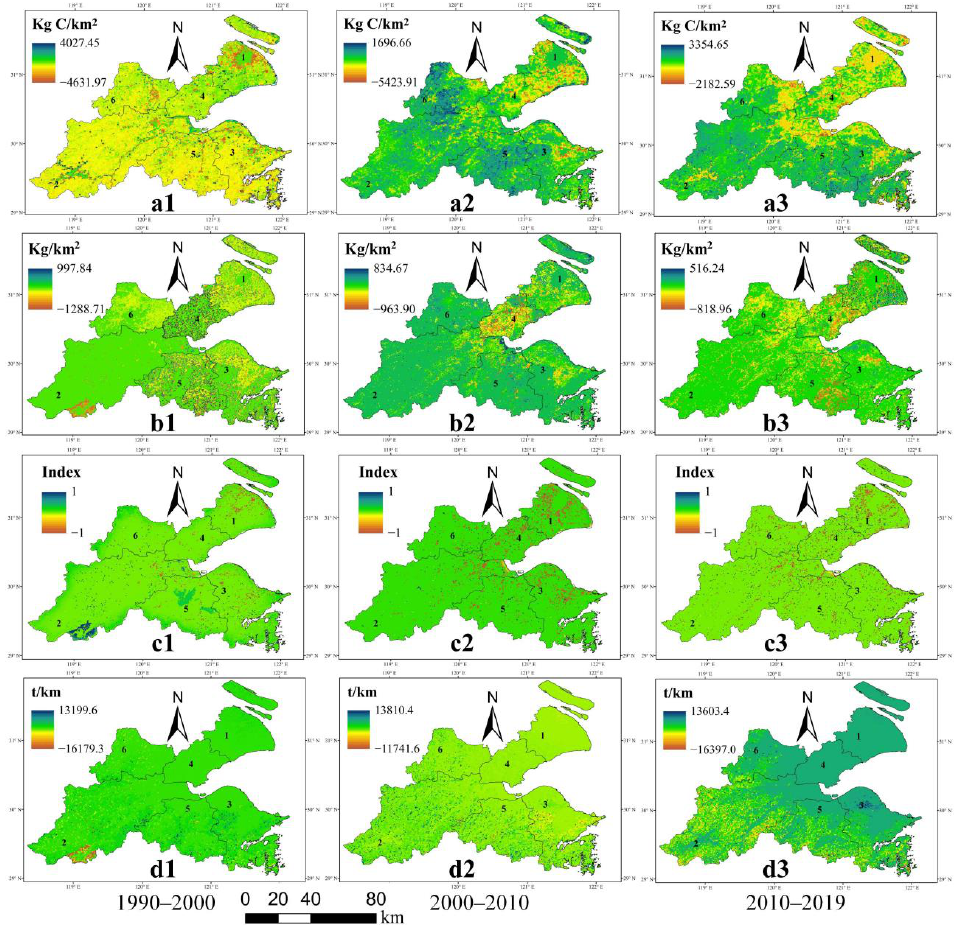
Figure 8. Spatial differences of ESs in SHB from 1990 to 2019: ( a ) Carbon sequestration; ( b ) Food supply; ( c ) Habitat quality; ( d ) Soil